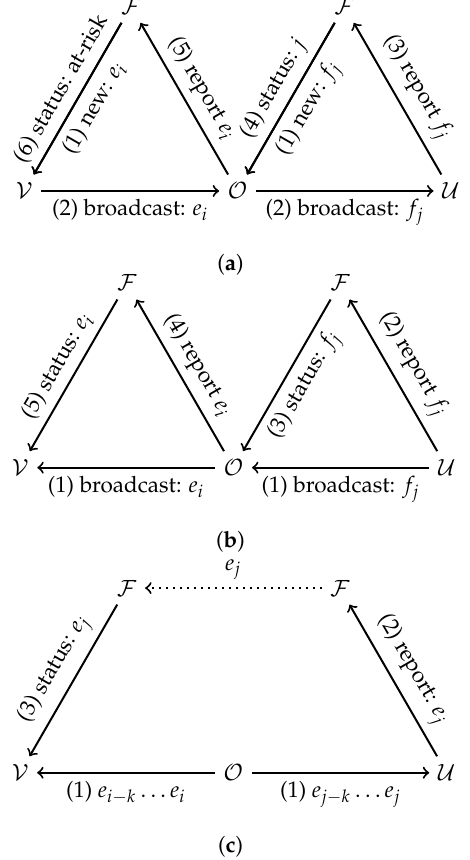
Figure 2. Ephemeral identifier CT with IoT devices. ( a ) Direct and centralized: (1) FE F identifiers to UE and OE . (2) records contact with and UE records contact with . (3) V O O V U O U is diagnosed, reports incoming identifiers containing f j to . (4) alerts of at-risk status at time j . F F O (5) reports identifiers e i received in a short interval after time j . (6) notifies of risk status. ( b ) O F V Direct and decentralized: (1) OE records contact with UE and UE records contact with . (2) O U V O is diagnosed, reports f j to FE . (3) alerts of new status of identifiers f j . (4) evaluates its U F F O O risk and reports e i broadcasted in a short interval after receiving f j as at-risk. (5) forwards e i to F V who computes its risk. ( c ) Indirect and decentralized: (1) OE broadcasts rolling window of ids to O UEs. (2) UE is diagnosed, reports e j to FE . (3) sends e j to UE that correctly identifies risk U F F V status if i j < k . −